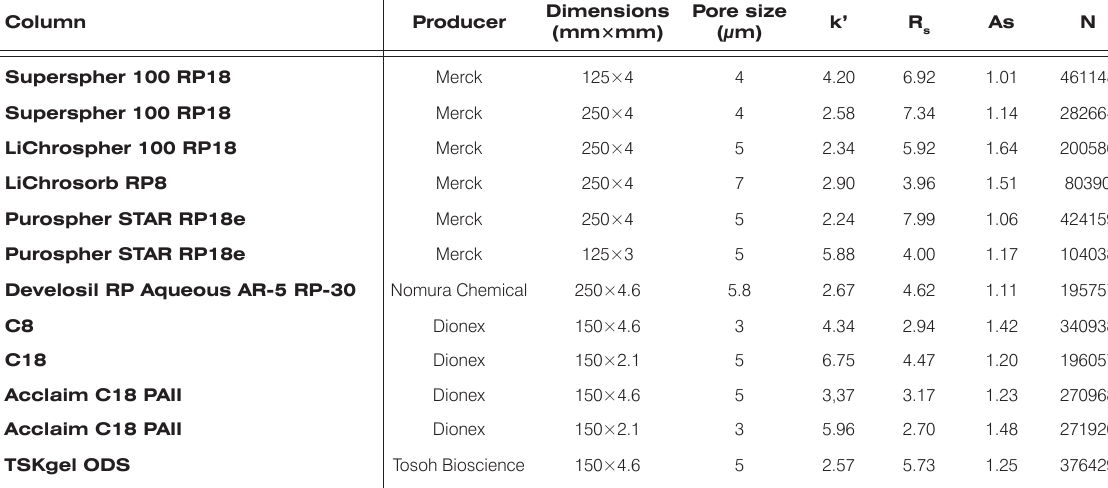
Table 3. Isoflavones content of urine and plasma samples (n=6).